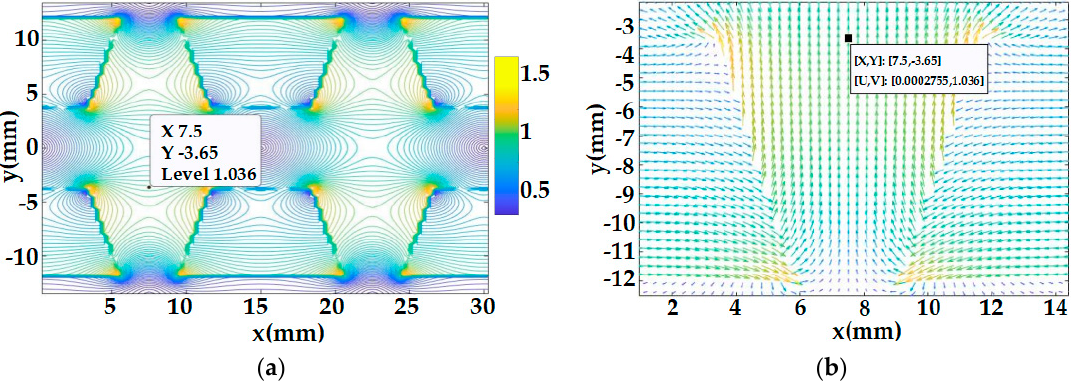
Figure 5. Distribution diagram of air gap magnetic field ( α = 75 ◦ ): ( a ) distribution cloud diagram of |B| and ( b ) localized view of magnetic induction vector B .